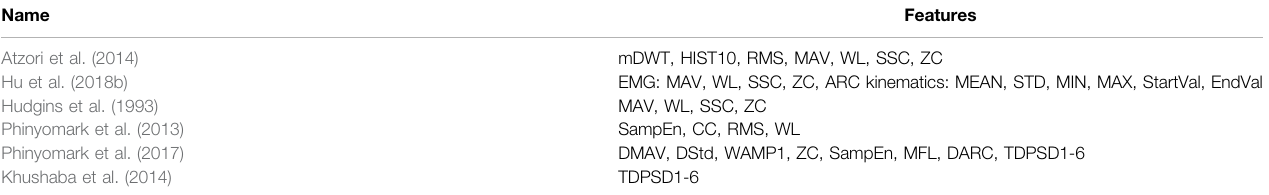
TABLE2| Sixstate-of-the-artfeaturesetsusedinmyoelectriccontrol.Inthiscase,thefeaturesetusedbyHuetal.(2018b)wastheonlysetthatcontainedseparatefeatures for kinematic data. Feature de fi nitions can be found in Table 1 .